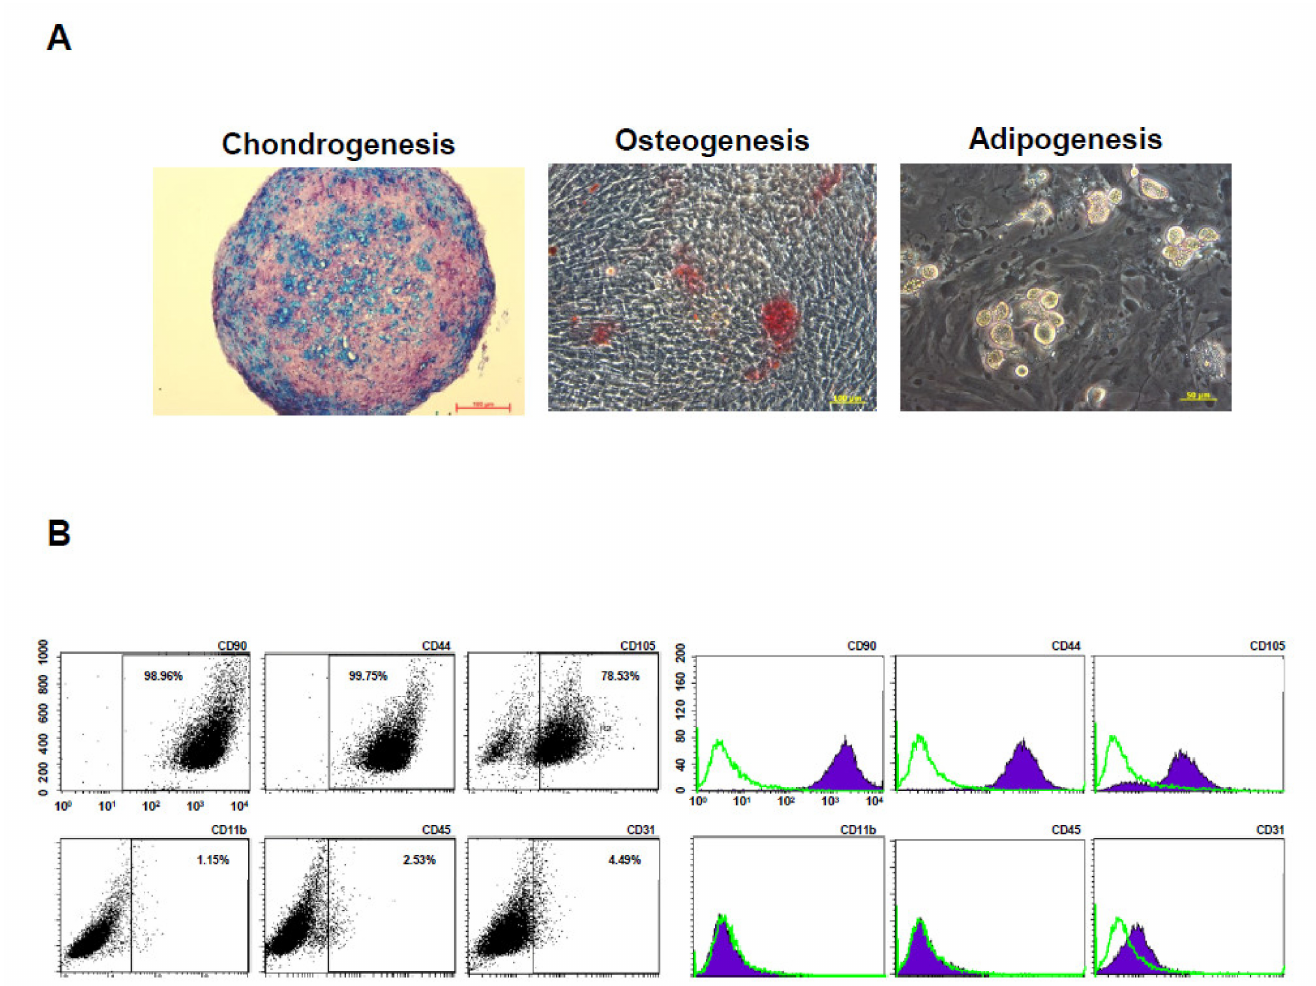
Figure 4. Characterization of pMSCs by tri-lineage differentiation and surface markers. ( A ) Represen- tative images of in vitro tri-lineage differentiation potential of porcine bone marrow MSC (BM-pMSC) toward chondrogenic, osteogenic, and adipogenic lineages confirmed by histochemical staining with Alizarin red, Oil red O, and Alcian blue staining, respectively. BM-pMSCs exhibited multi- differentiation capacity of adipogenesis, osteogenesis, and chondrogenesis. ( B ) Representative results of flow cytometric analysis for cell surface markers using freshly isolated BM-pMSC from porcine. The population is positive for previously described MSC markers (CD90, CD44, and CD105) and negative for CD11b, CD45 and CD31 expressions from passages